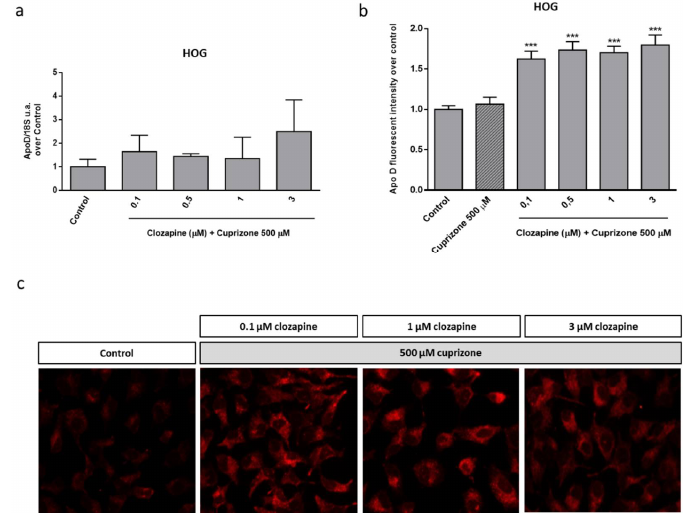
Figure 5. Relative Apo D gene expression in HOG cells treated with increasing concentrations of CLO (0.1–3 µM) during 24 h followed by 24 h with 500 µM of CPZ. Data represent the quotient between the gene and the expression of the house- keeping gene 18S rRNA. Bars represent the mean ± SEM of all measurements ( n = 6–8) ( a ). Densitometric quantification of Apo D immunocytochemical signal after 24 h of treatment with increasing concentrations of CLO (0.1–3 µM) followed by 24 h with 500 µM of CPZ ( n = 6). Bars represent mean density per cell in a 40× field ± SEM (over control) ( b ). Representative fluorescence microscopy images of Apo D expression in HOG cells treated with increasing concentrations of CLO (0.1–3 µM) followed by 24 h with 500 µM of CPZ. 40× magnification ( c ). Significant differences were analyzed by a one-way ANOVA followed by post-hoc Tukey’s test. *** p < 0.001 compared with control.